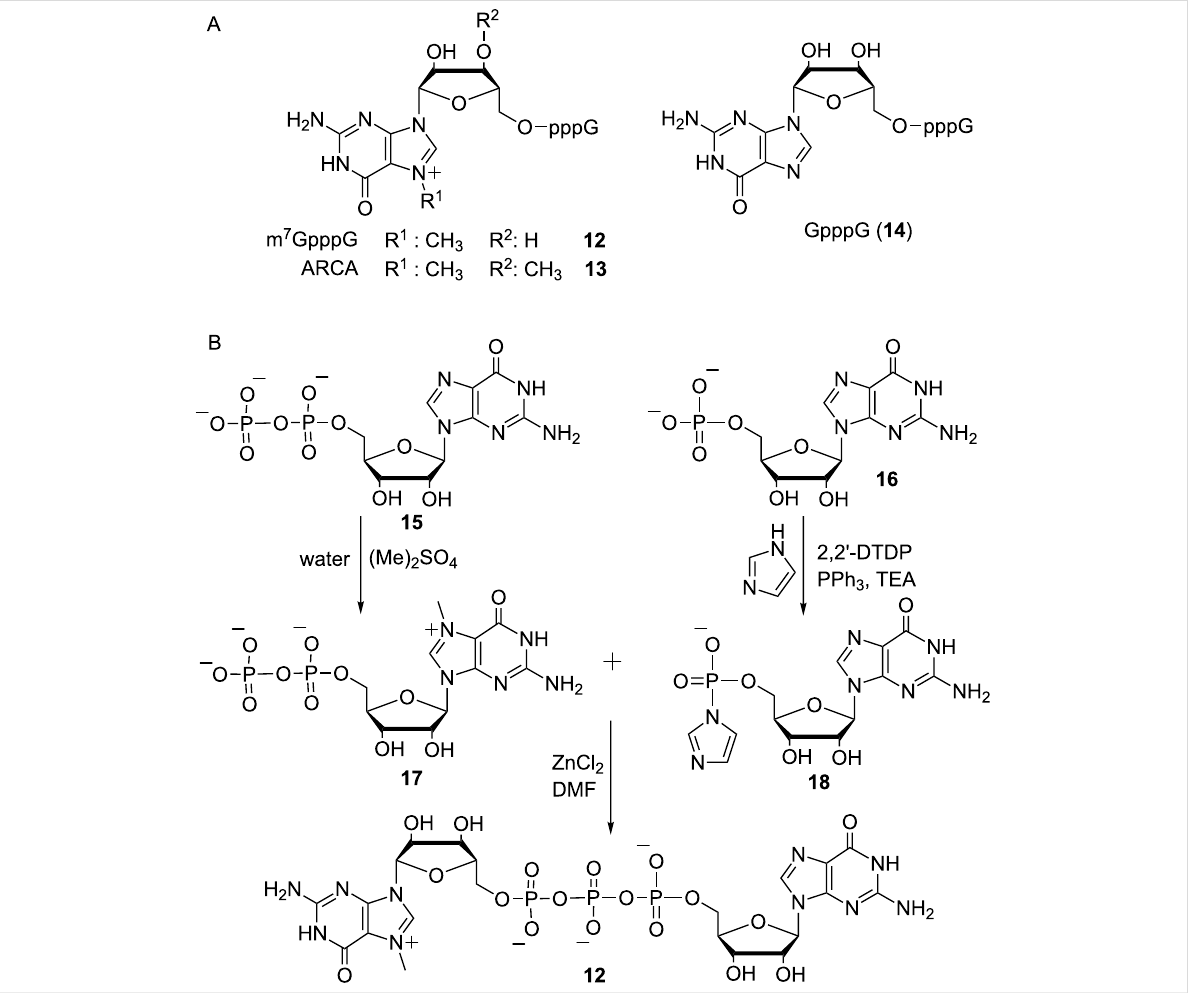
Figure 4: (A) Structures of commercially available mRNA cap analogues. (B) Synthetic route to cap analogues as exemplified by the synthesis of the m 7 GpppG cap analogue. 2,2 ′ -DTDP: 2,2 ′